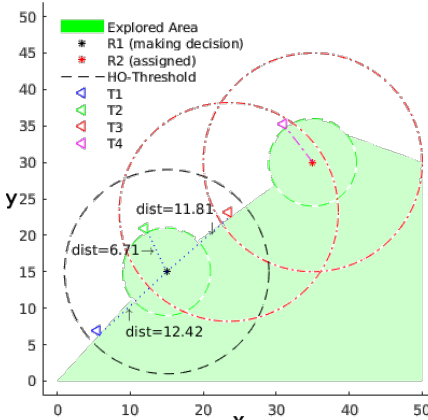
Figure 7. Two robots are carrying out an exploration mission. The communication and sensory ranges are drawn around the robots with red and green dashed lines, respectively. It is assumed that R 2 has already chosen the task T 4 whereas R 1 is still selecting from T 1 , T 2 , and T 3 . Dotted lines are used to show the sight-line between R 2 and the tasks. The corresponding Euclidean distance is also shown. HO-Threshold is set to 6.